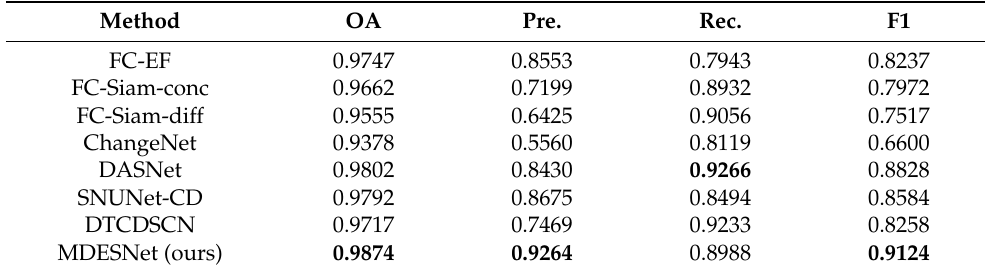
Table 4. Comparative study of several change detection methods on the BCDD